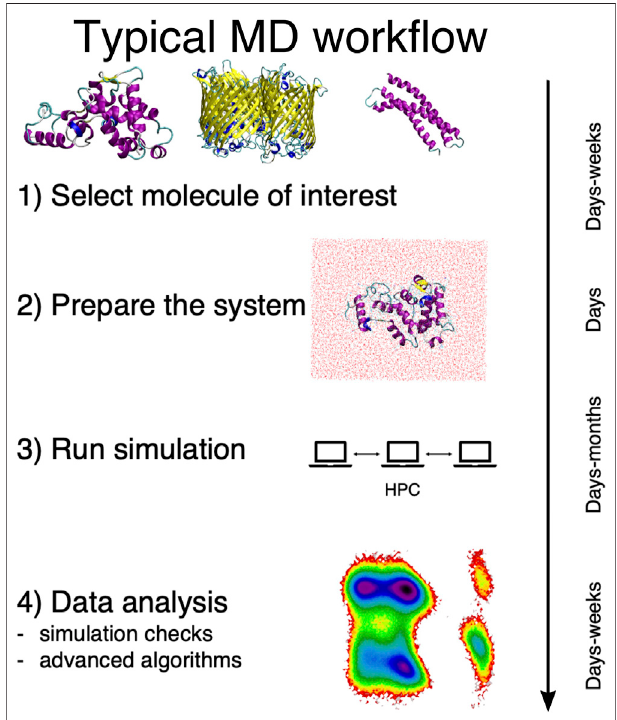
FIGURE 1 | Schematic representation of the typical work fl ow of a molecular dynamics study. On the right we report the average time scales required for each step of the